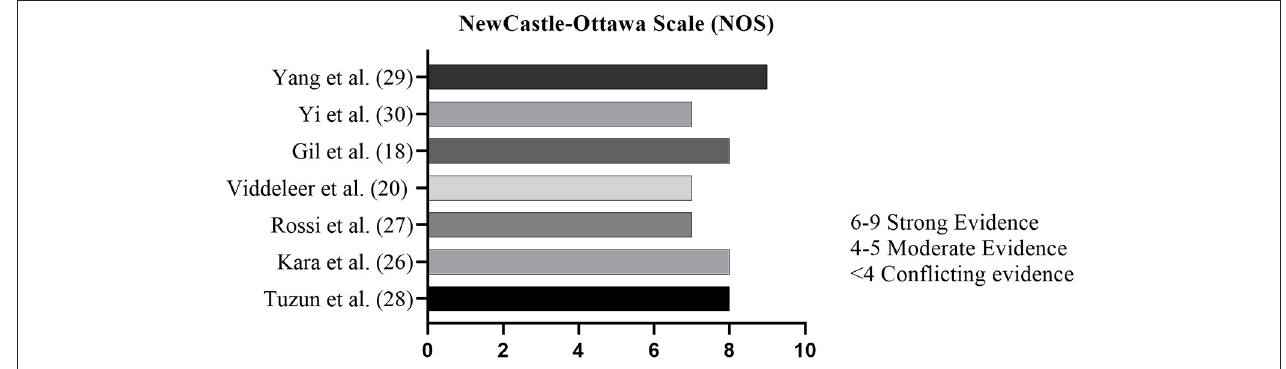
FIGURE 2 | The Newcastle-Ottawa Scale (NOS).